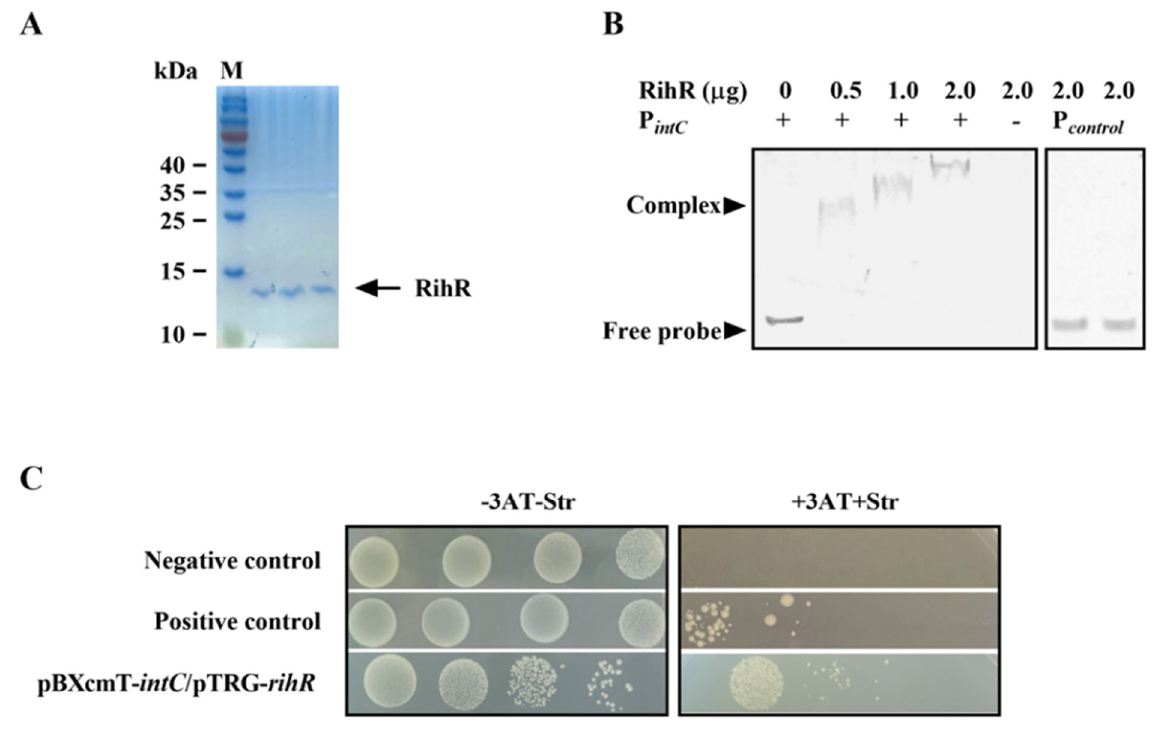
Figure 5. RihR binds on the promoter region of intC with high affinity. ( A ) The purified RihR protein was analyzed through non-reducing SDS-PAGE. The soluble proteins in cells were washed down by the elution buffer and added to the three lanes. The arrow indicates the location of RihR protein. M: marker. ( B ) EMSA assay, RihR protein binds on the intC promoter. The DNA fragment containing the intC promoter was incubated with increasing concentrations of RihR protein at room temperature. The concentration of DNA fragments in the reaction system was 50 ng. The mixture was separated on polyacrylamide non-denaturing gel to observe the DNA-protein complex. ( C ) The B1H assay of the interaction between RihR and intC promoter. Co-transformant strains containing the plasmids pTRG-R3133, pBXcmT-R2031 and pTRG, pBXcmT served as positive control and negative control, respectively.